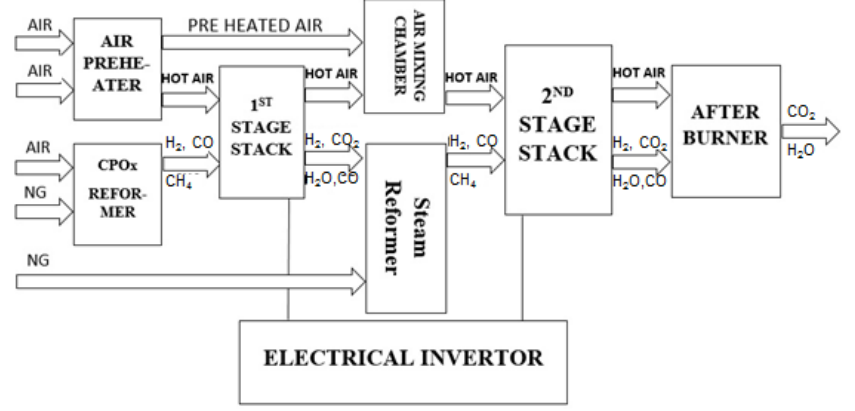
Figure 1. Simplified schematic diagram of the power (solid oxide fuel cell) SOFC-based system.